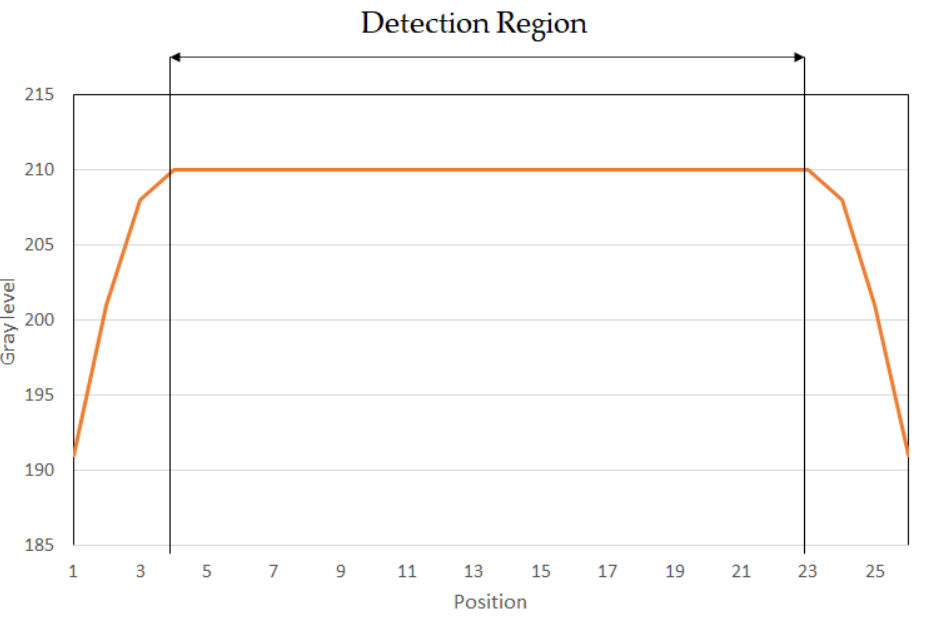
chose the uniformity brightness as a detection region.